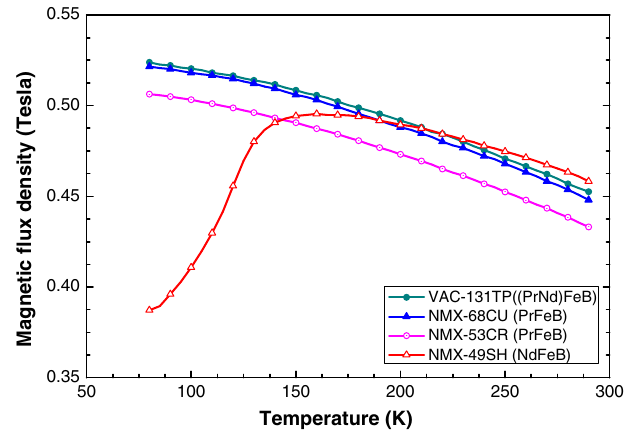
FIG. 4. Temperature dependence of the magnetic field density in various magnets [48]. The dimensions of all samples are 10 mm ð W Þ × 10 mm ð L Þ × 5 mm ð H Þ (the magnetization direction) with the same permeance close to